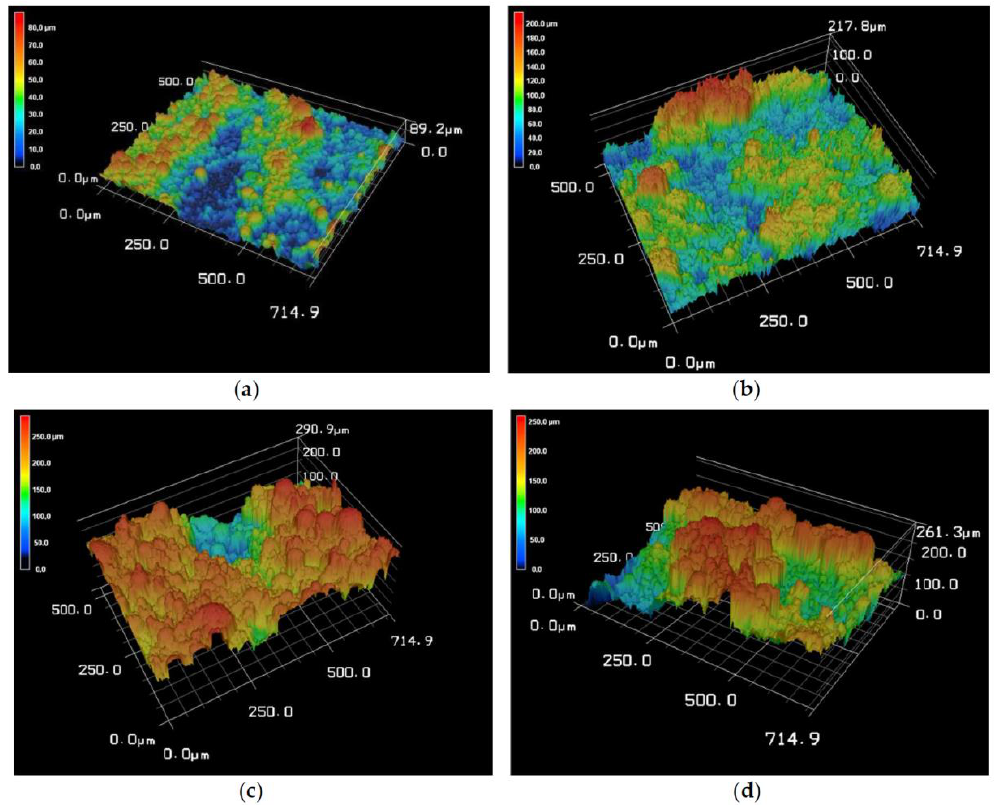
Figure 4. 3D reconstruction of Surface of composites: depending on the different composition and particle size of used granules, a different surface roughness can be observed: ( a ) BG; ( b ) β-TCP; ( c ) 50/50; and ( d ) 70/30. Images were taken with Keyence VK-X210. Magnification, 400×.